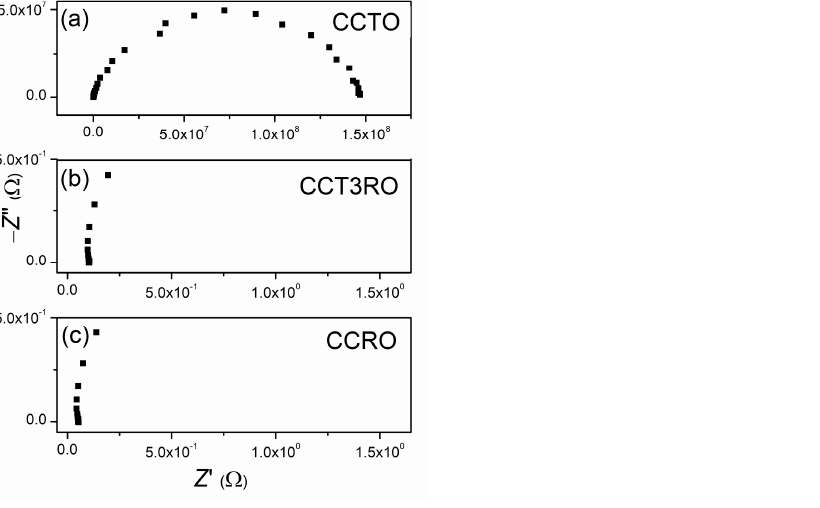
Figure 6. Complex impedance spectra recorded at room temperature for sintered ceramics: ( a ) CCTO, ( b ) CCT3RO, and ( c ) CCRO. Table 3. Dependence of the electrical conductivity and the frequency value at room